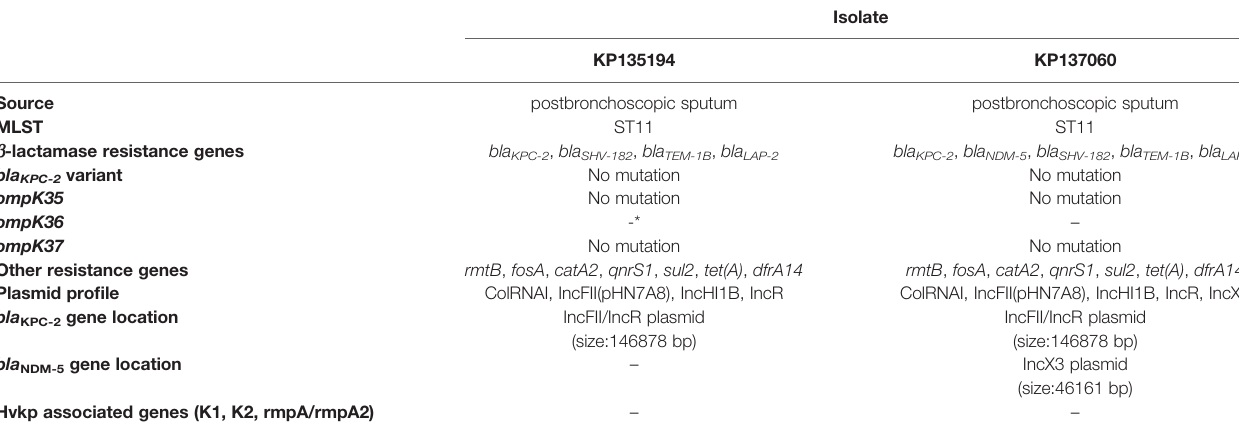
TABLE 2 | Genetic characteristics and source of two CR-KP